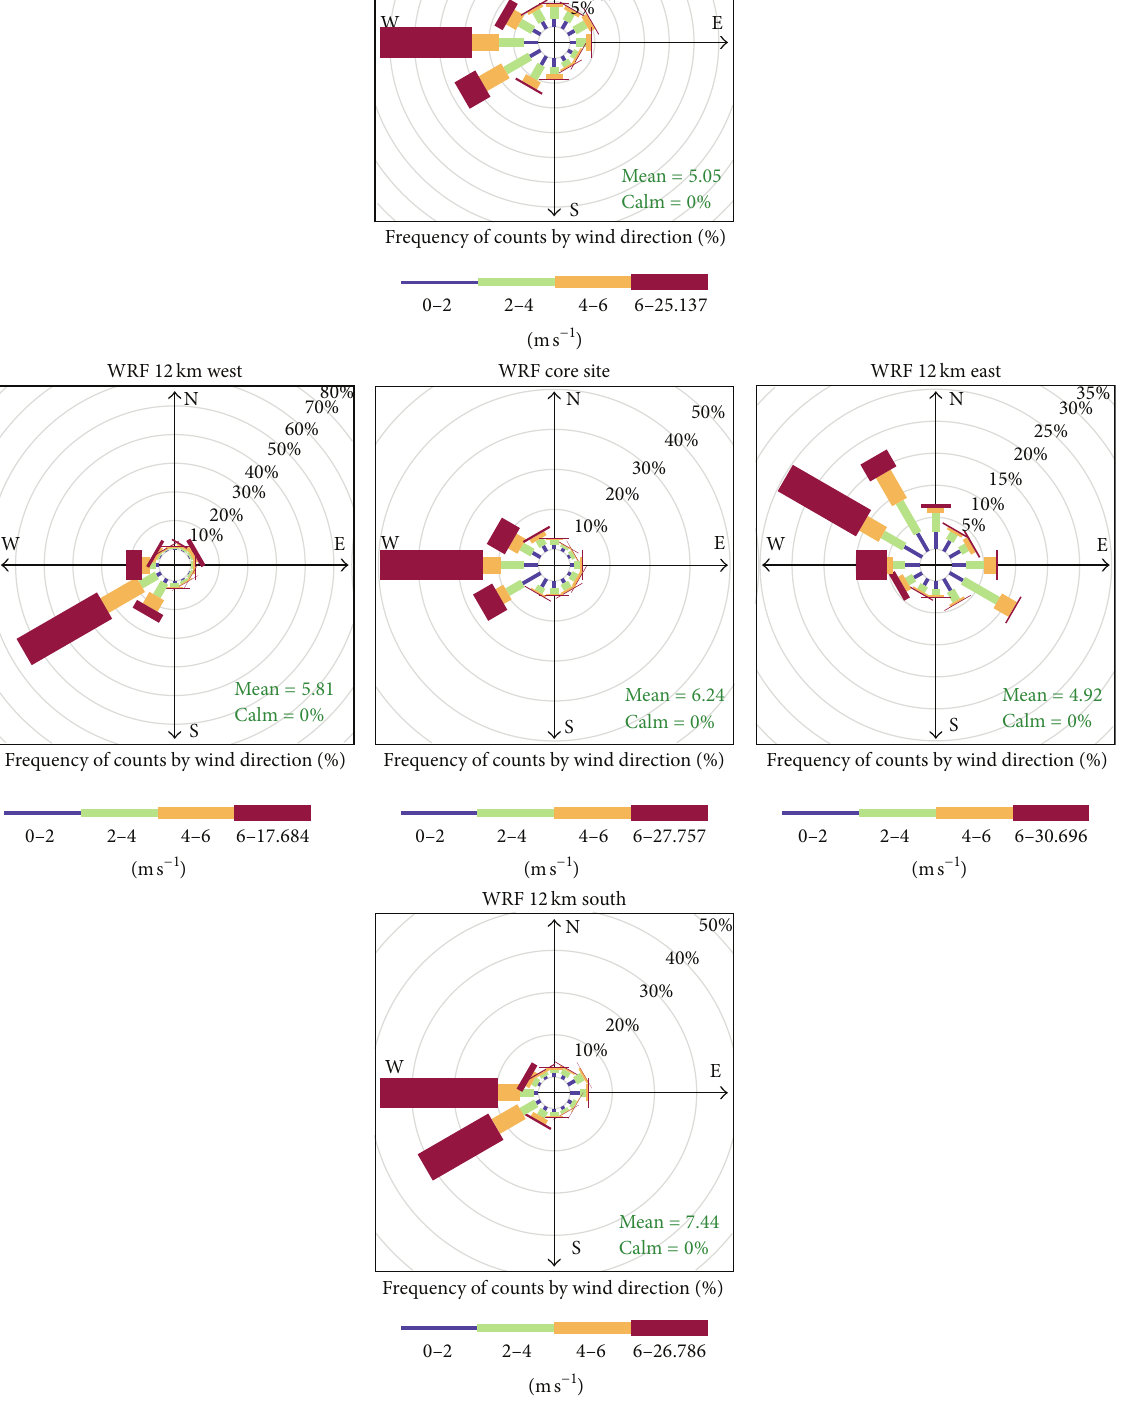
Figure 7: Wind roses showing the percent of winds from each of 12 directional bins for 10-meter winds during November 2008 through November 2009 as modeled by WRF at the core site and at sites located 12 km in each of the cardinal directions. Wind speeds are indicated by the colors as shown in the